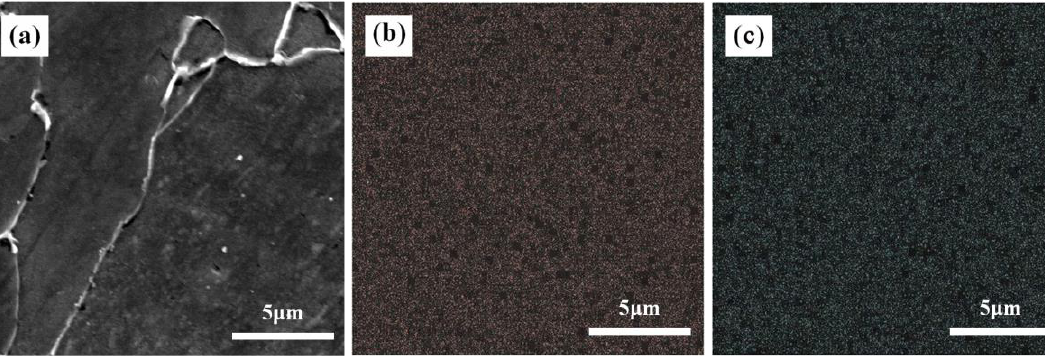
Figure 9. SEM photograph and energy spectrum. ( a ) Scanning area; ( b ) Sb energy spectrum; ( c ) Sn energy spectrum.